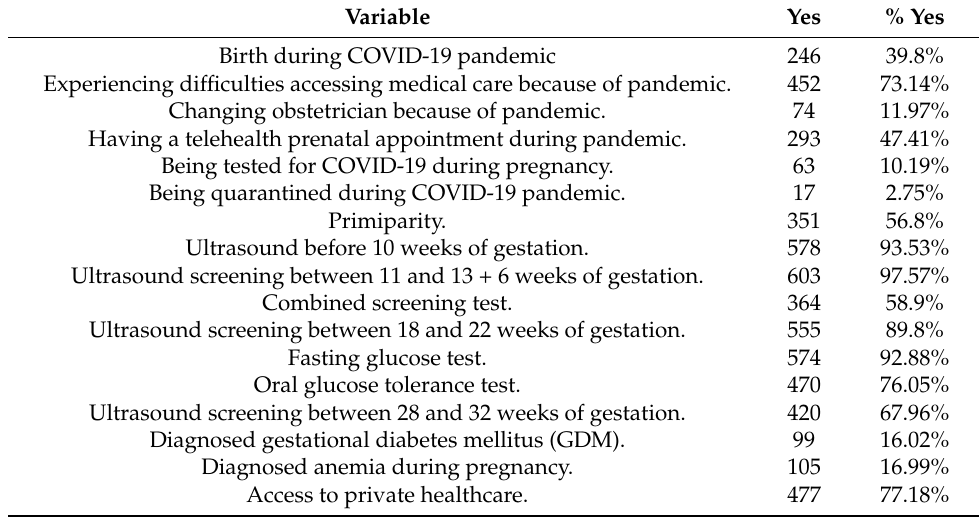
Table 1. Characteristics of the study group. Variable Experiencing difficulties accessing medical care because of